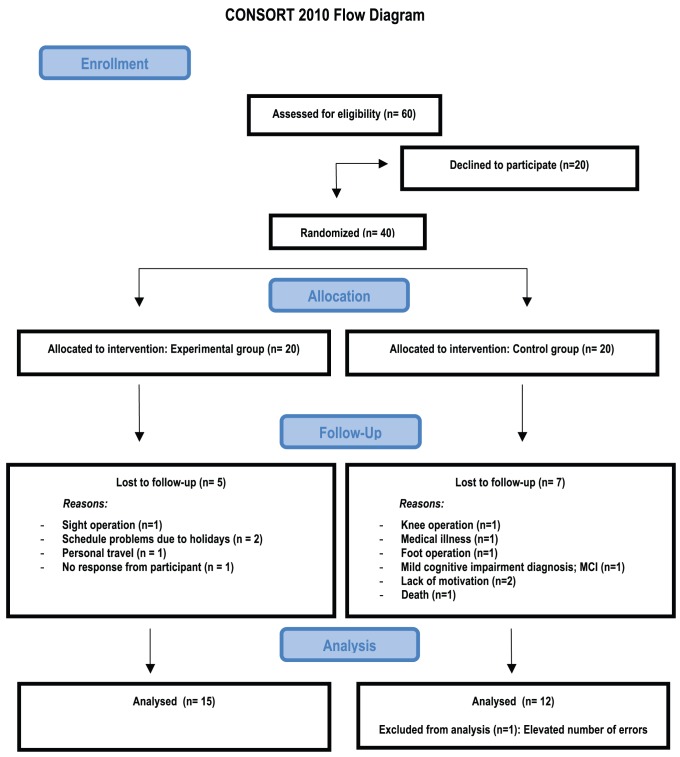
CONSORT flowchart.